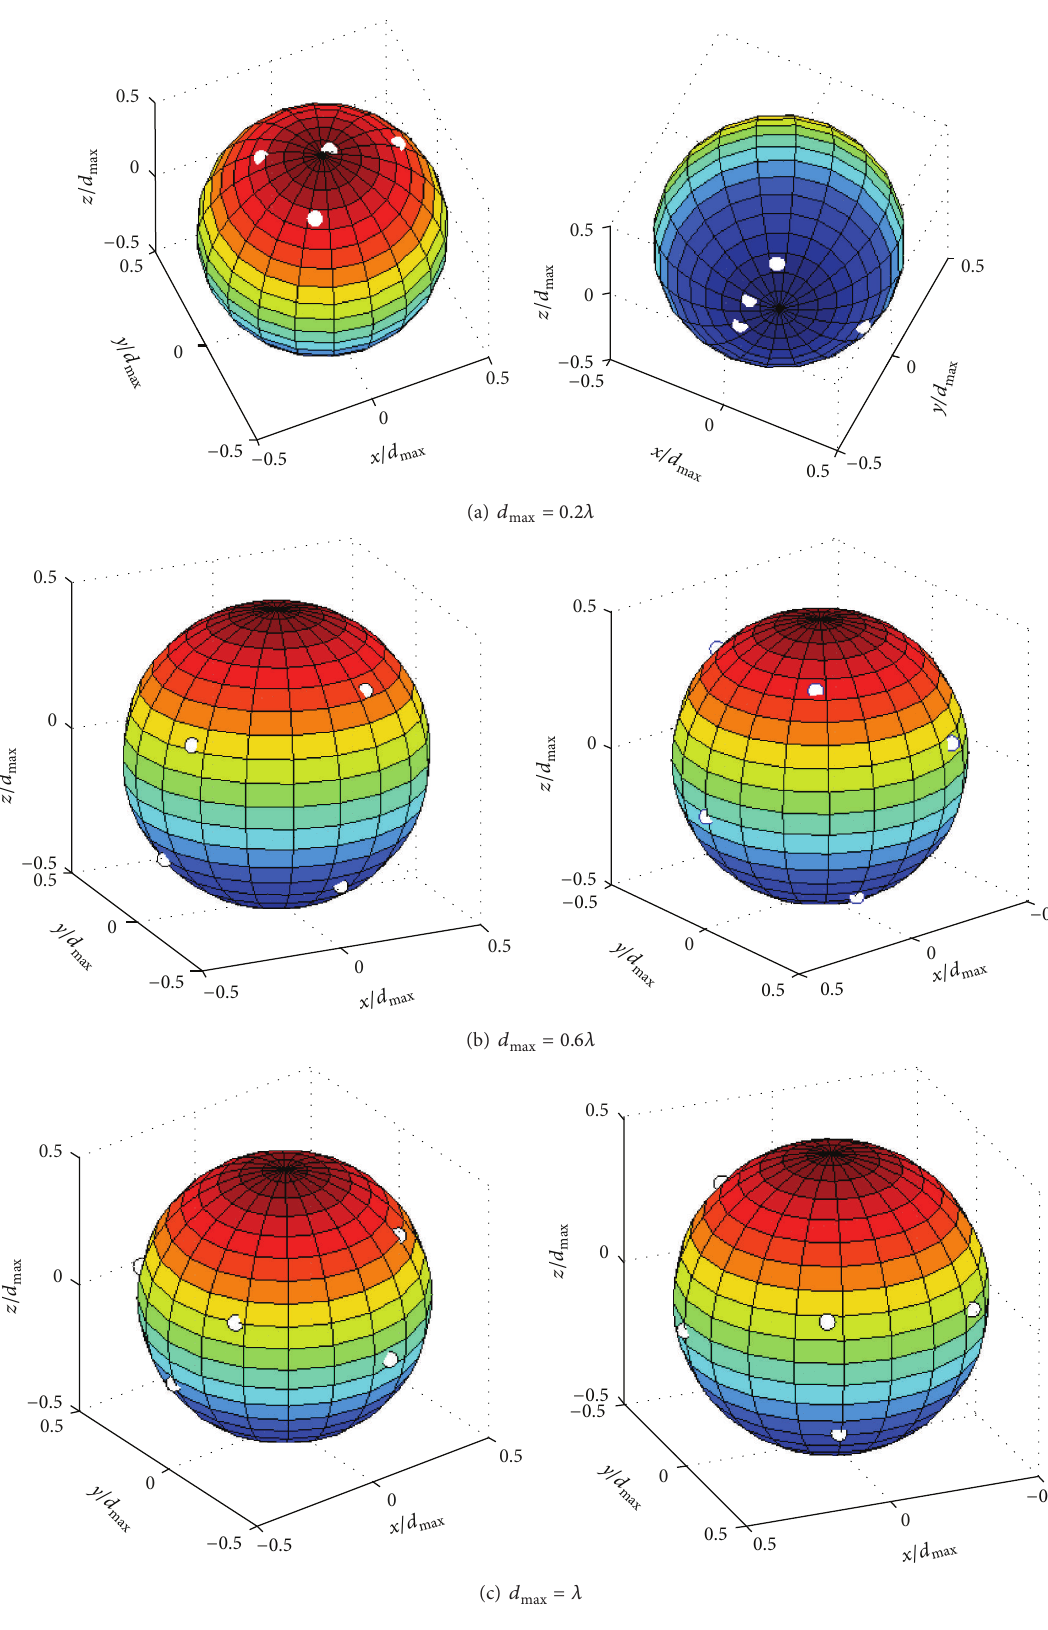
Figure 3: The optimal layout for Scenario